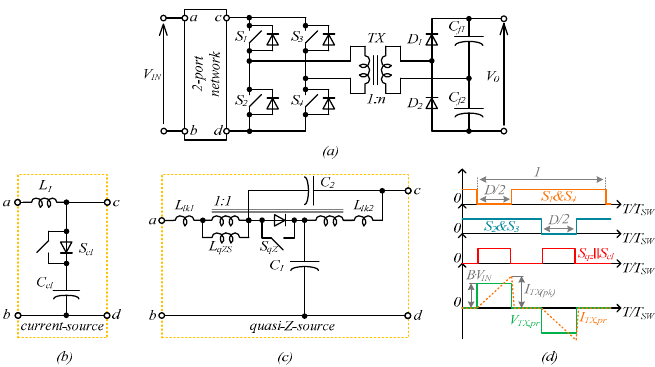
Figure 9. Generalized topology of high step ‐ up galvanically isolated dc ‐ dc converters ( a ) that can be implemented as either ( b ) active ‐ clamped current ‐ source (CS) or ( c ) qZS and feature ( d ) a triangular transformer current.